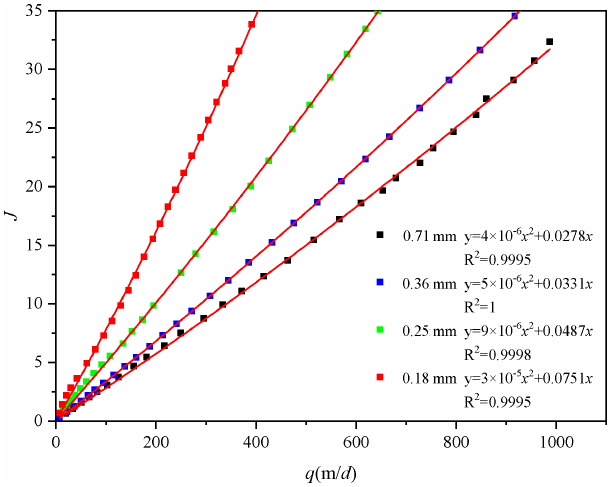
Figure 4. Variation of J with q for four permeable stones with dif- ferent particle sizes.